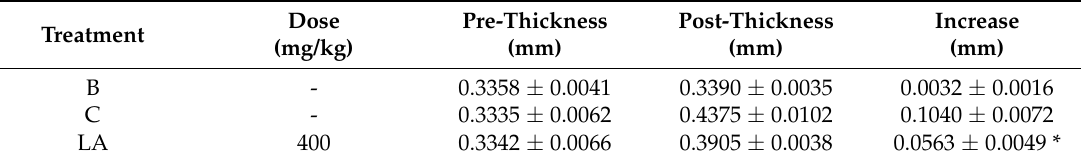
Table 1. Effect of LA on PMA-induced ear edema in